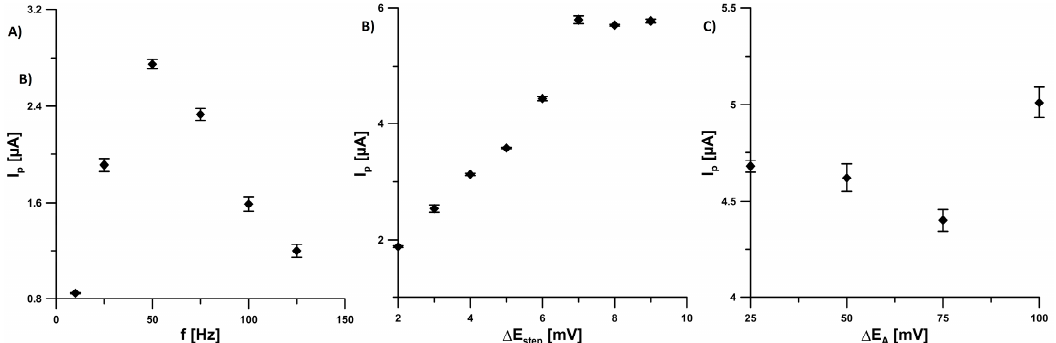
Figure 6. E ff ect of ( A ) f (10–125 Hz), ( B ) ∆ E step (2–9 mV) and ( C ) ∆ E A (25–100 mV) on 5.0 × 10 − 7 mol L − 1 EIMTC responses. The average values of I p are shown with the standard deviation of n = 3.